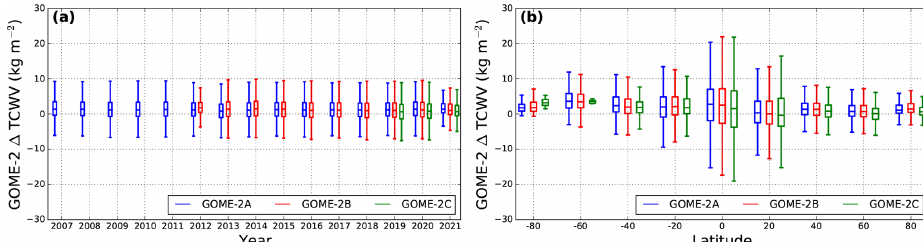
Figure 21. Comparison of TCWV between the sun-photometer and GOME-2 observations. Data are sorted by year in panel (a) and latitude in panel (b)